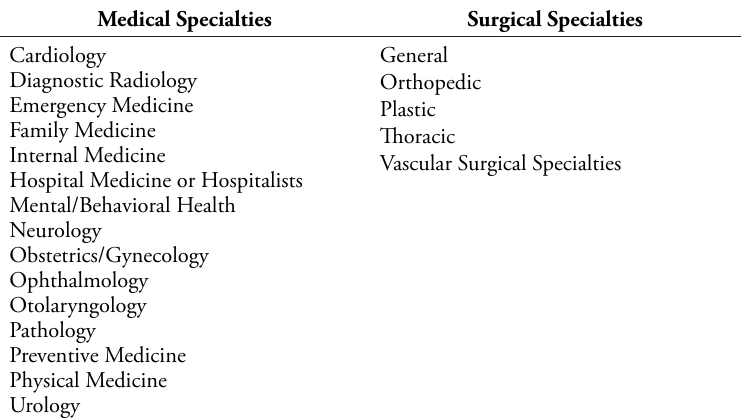
Table 2. Clinical Specialties Analyzed in This Study Medical Specialties Surgical